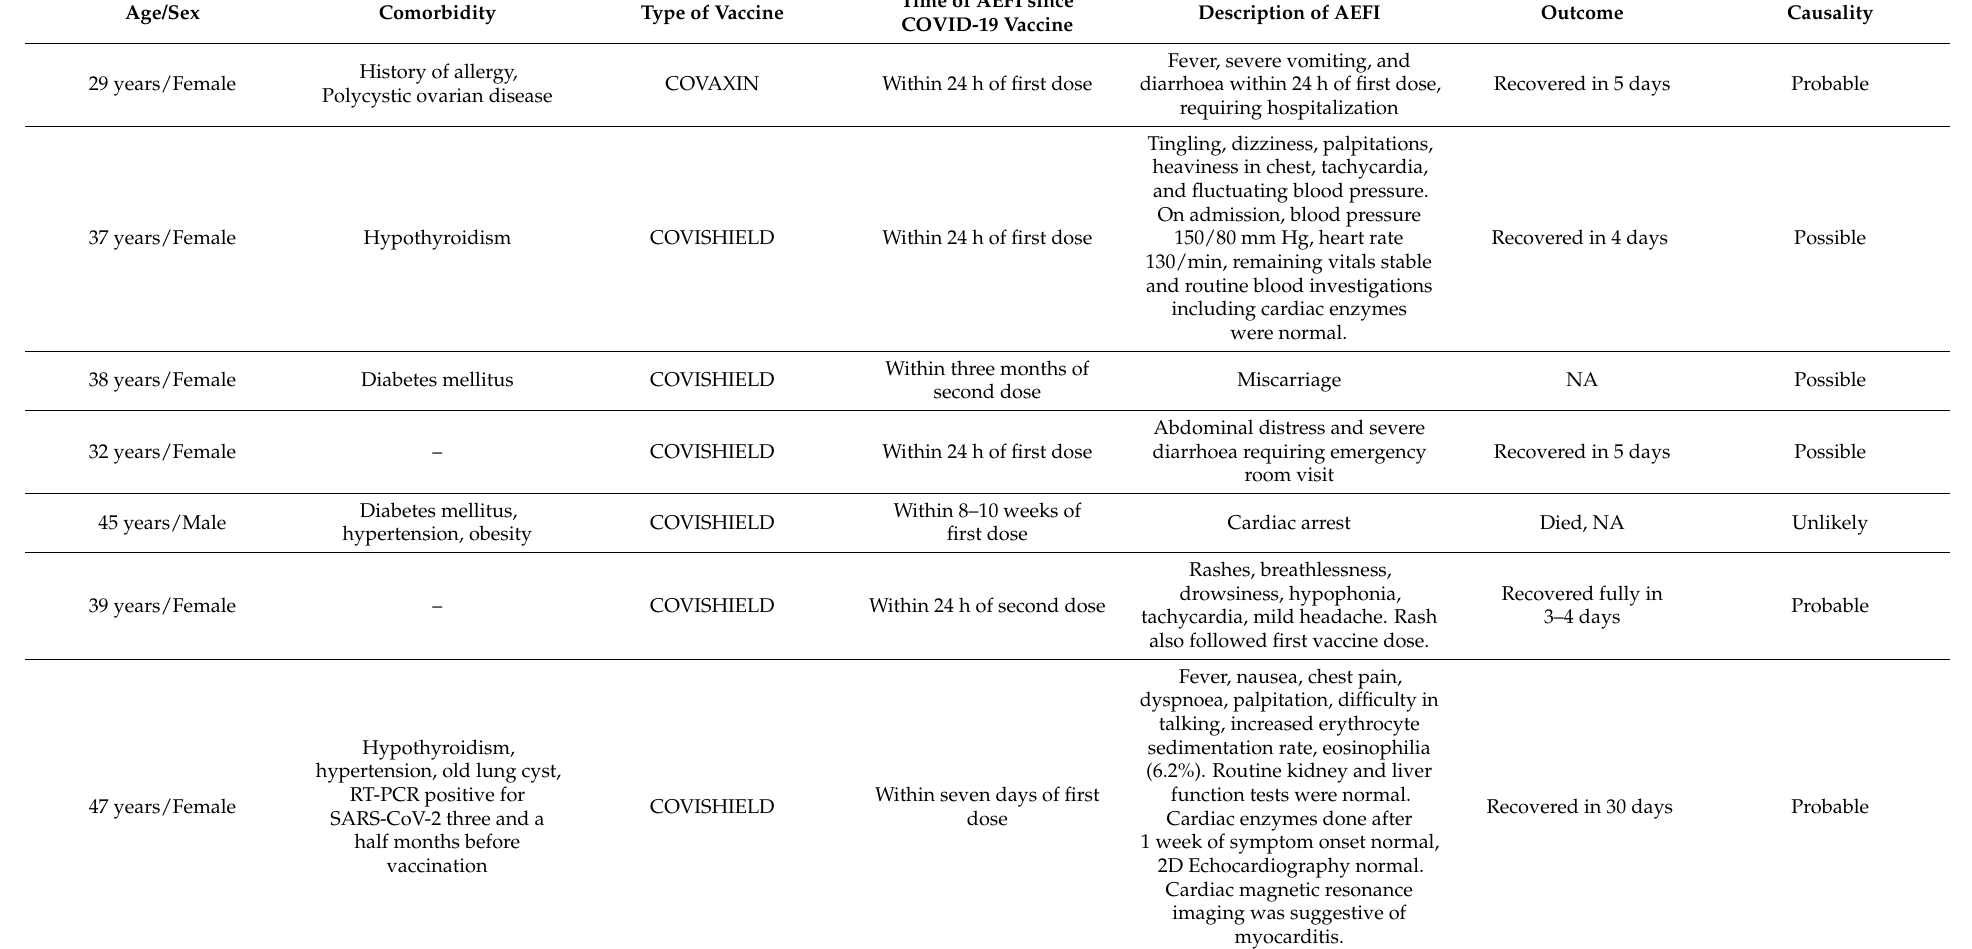
Table 5. Serious AEFIs following